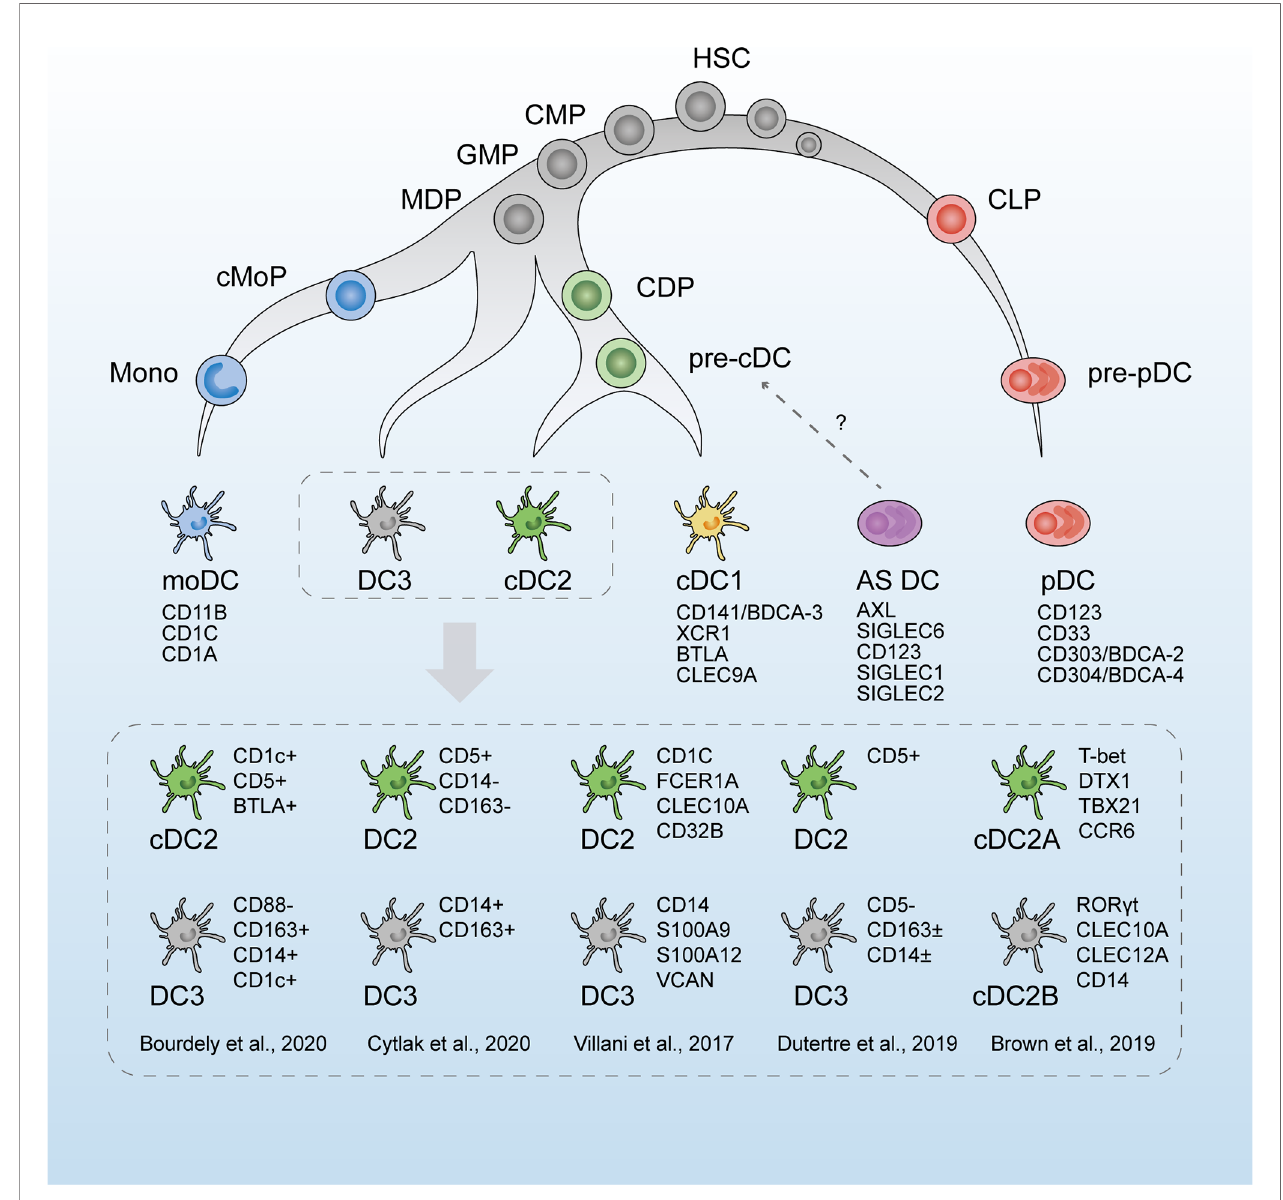
FIGURE 1 | The revised developmental trajectory and classi fi cation of human dendritic cells (DCs). The revised developmental trajectory of the DC lineage is continuous, with progenitors already committed to different lineages at the early stages. The classic DC subsets (moDCs, cDC1s, cDC2s, and pDCs) are present. Previous homogenous subset cDC2s is considered heterogeneous, which is subdivided by different markers in scRNA-seq studies by Villani et al. (42), Brown et al. (43), and Dutertre et al. (44). Based on Bourdely et al. (45) and Cytlak et al. (46), DC3s are de fi ned as a new subset, separately derived from MDPs. The origin of pDCs is revised as the lymphoid progenitors. Whether AS DCs (AXL + SIGLEC6 + DCs) are cDC precursors remains to be veri fi ed. HSC, hematopoietic stem cells; CMP, common myeloid progenitors; CLP, common lymphoid progenitors; GMP, granulocyte macrophage progenitors; MDP, monocyte – macrophage DC progenitors; CDP, common DC progenitors; cMoP, common monocyte progenitor; Mono,